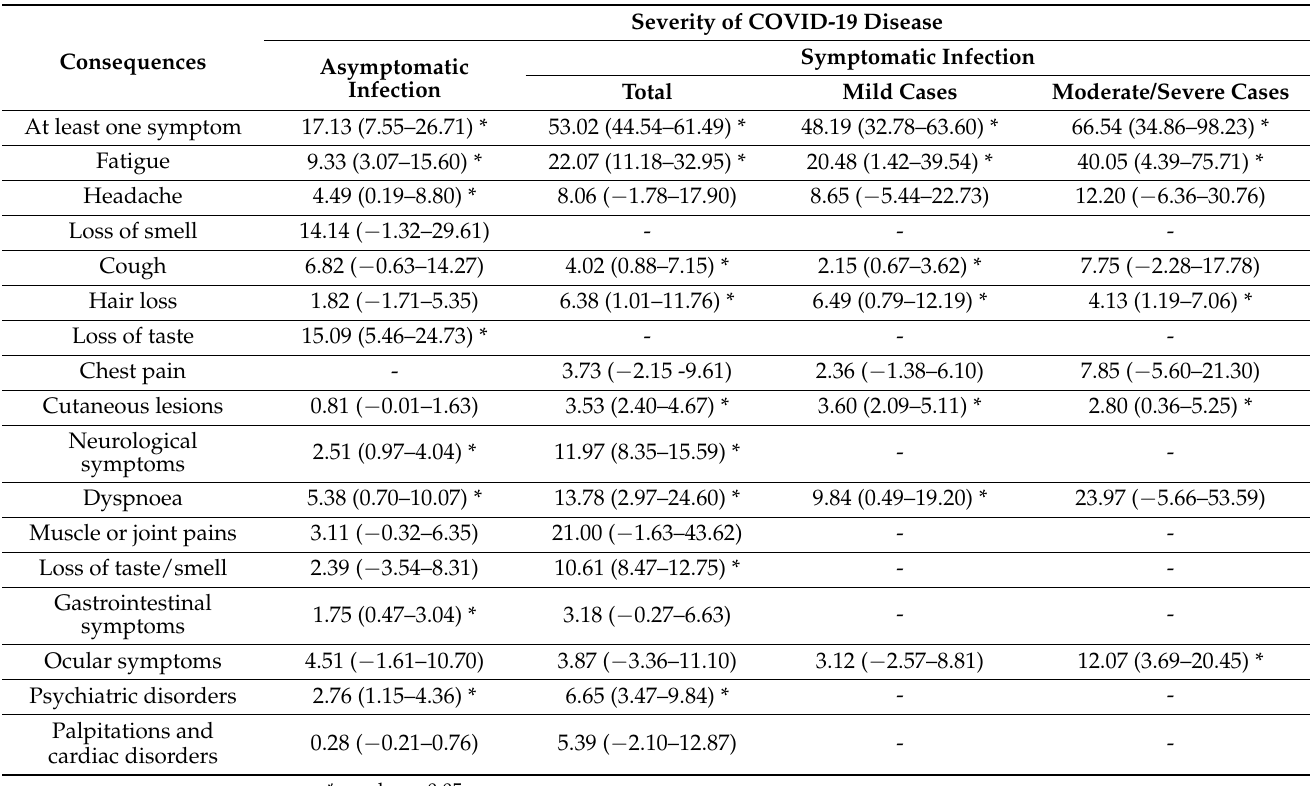
Table 3. Pooledprevalence(PP)oflong-termconsequencesinpatientswithdifferentseverityof COVID-19.